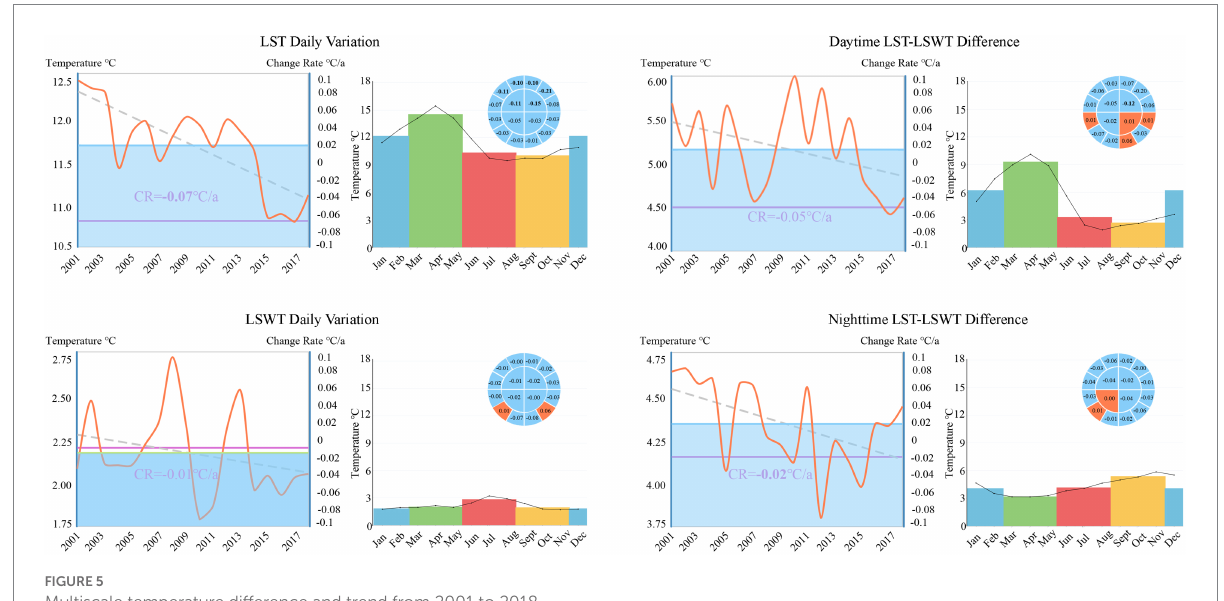
FIGURE 5 Multiscale temperature difference and trend from 2001 to